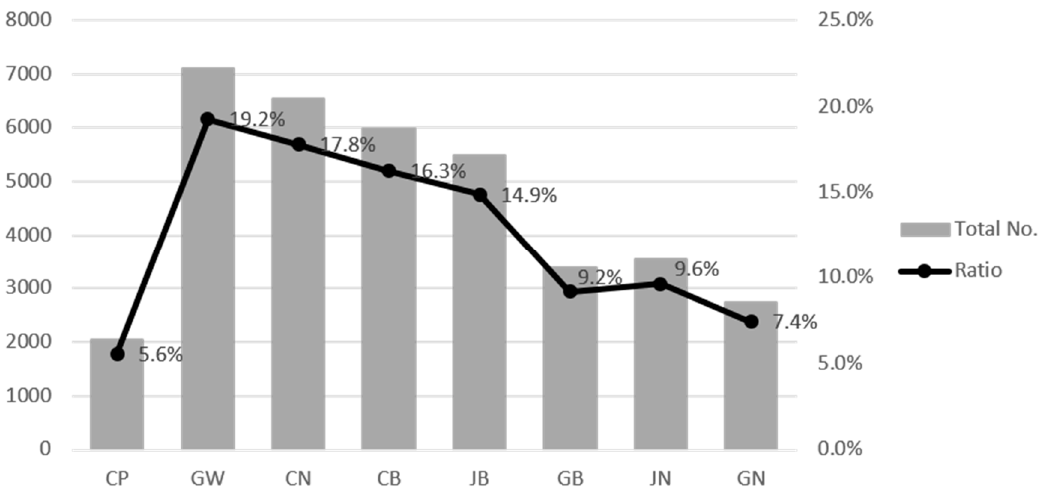
Figure 2. Total number and percentage (%) of roadkills by region on expressways in Korea between 2004–2019. (CP: Capital area, GW: Gangwon province, CN: Chungnam province, CB: Chungbuk province, JB: Jeonbuk province, GB: Gyeongbuk province, JN: Jeonnam province, GN: Gyeongnam